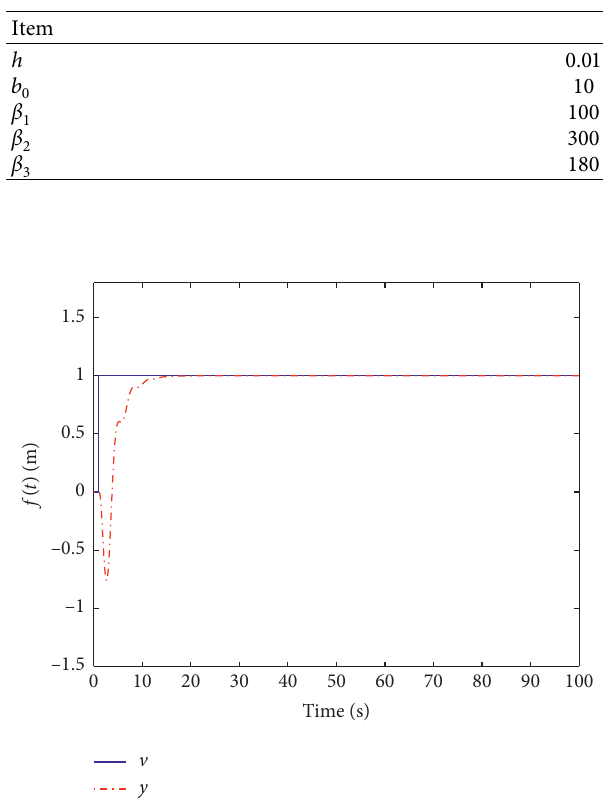
Figure 10: z and z . 3 4 Table 4: LSEF parameter table.